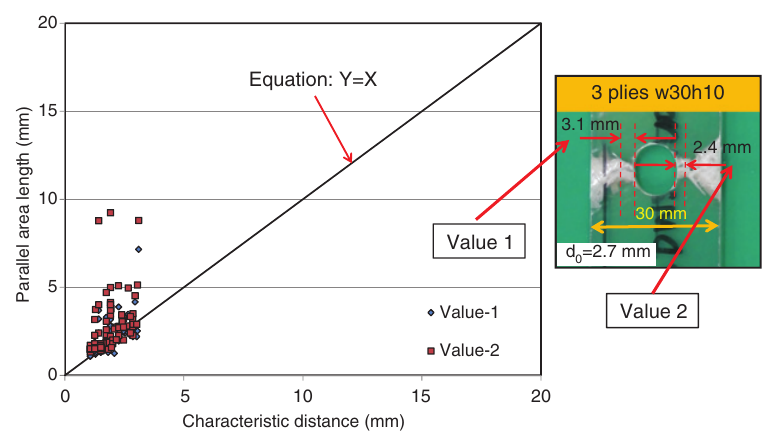
Figure 11 Correlation between characteristic distance and parallel area